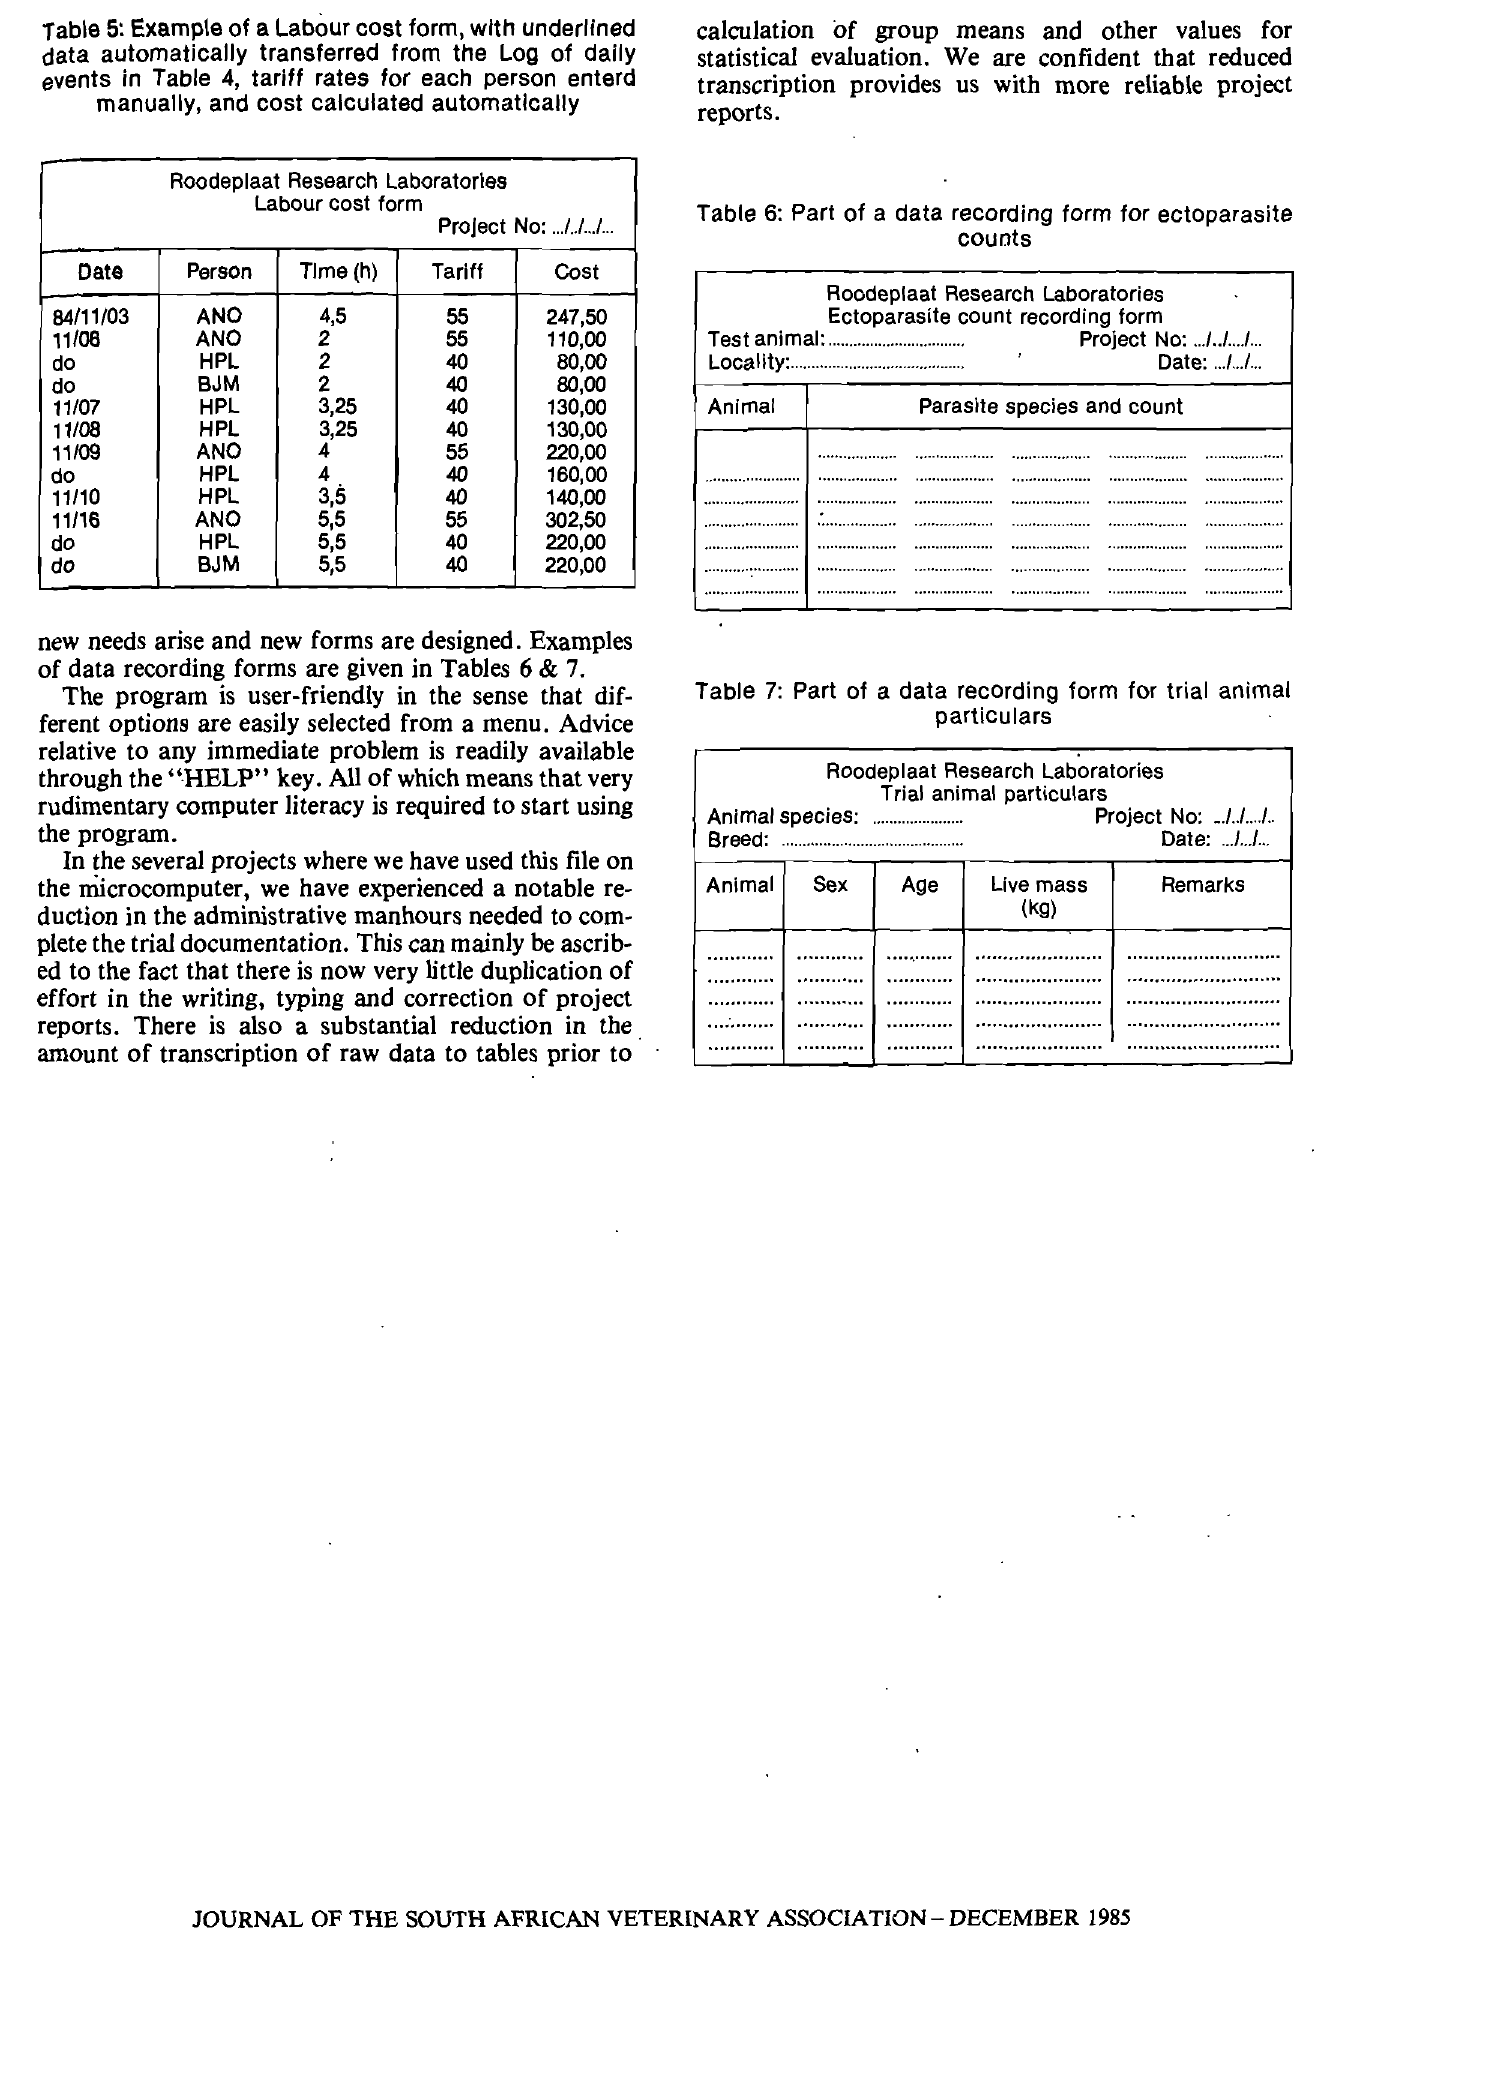
Table 6: Part of a data recording form for ectoparasite counts